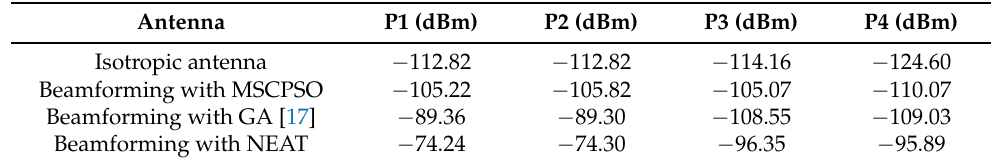
Table 4. Received power in each road for the isotropic antenna case and beamforming for different